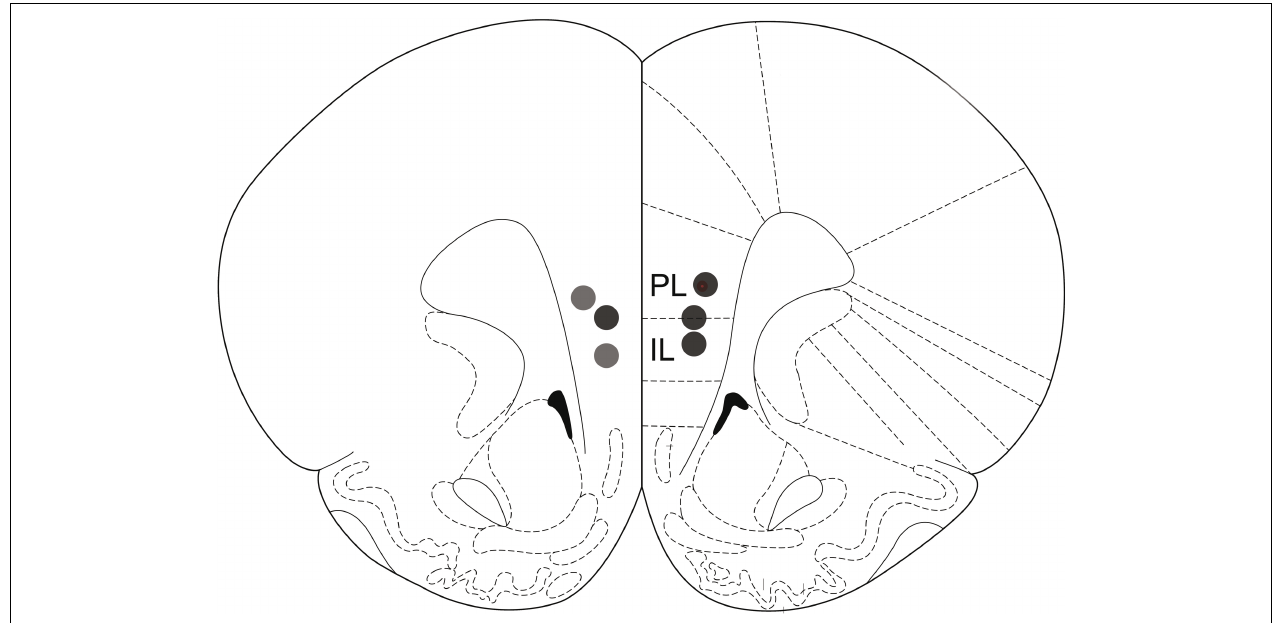
FIGURE 4 | Drug infusion sites. Filled circles indicate locations where infusion cannula tips were placed. PL: prelimbic cortex; IL: infralimbic cortex. Coronal brain section templates are from Paxinos and Watson (1998).